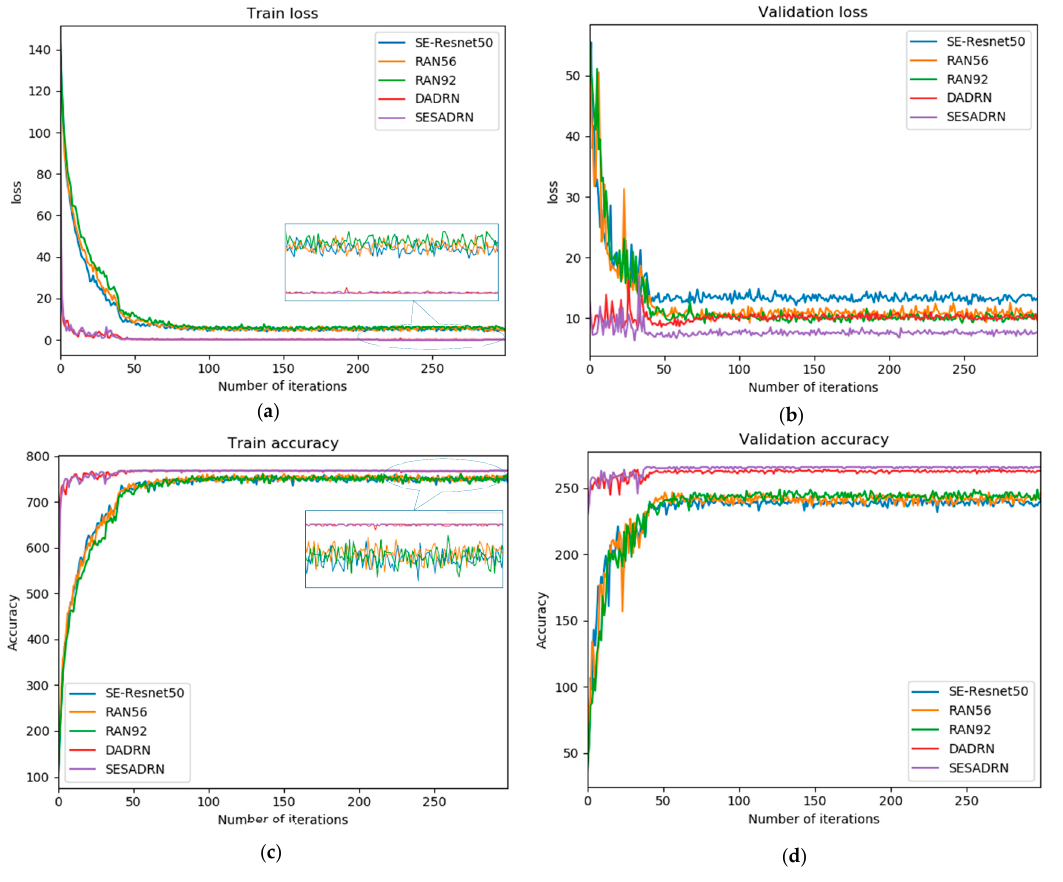
Figure 6. Accuracy and loss of training and validation. ( a ) Training loss of 300 epochs. ( b ) Validation